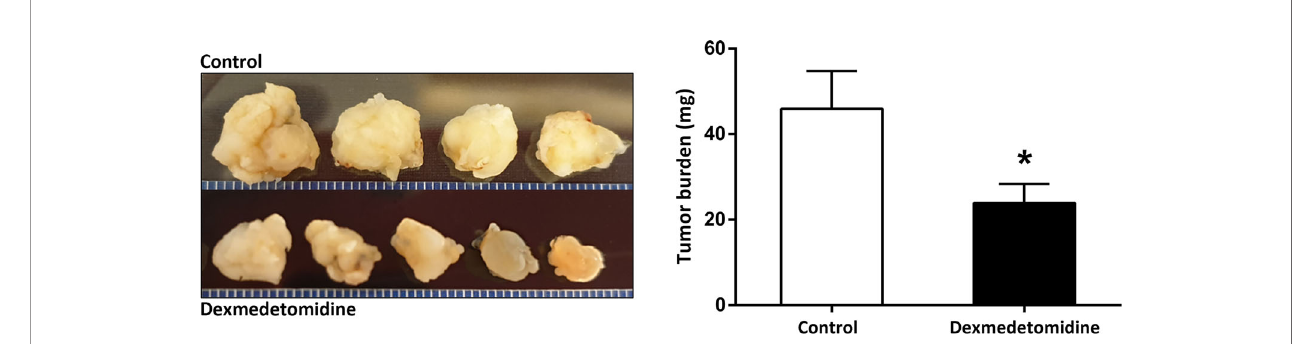
FIGURE 4 | Tumor size and weight at 4 weeks after surgery in the Control and Dexmedetomidine groups. * P < 0.05 compared to Control. Error bars represent standard deviation.